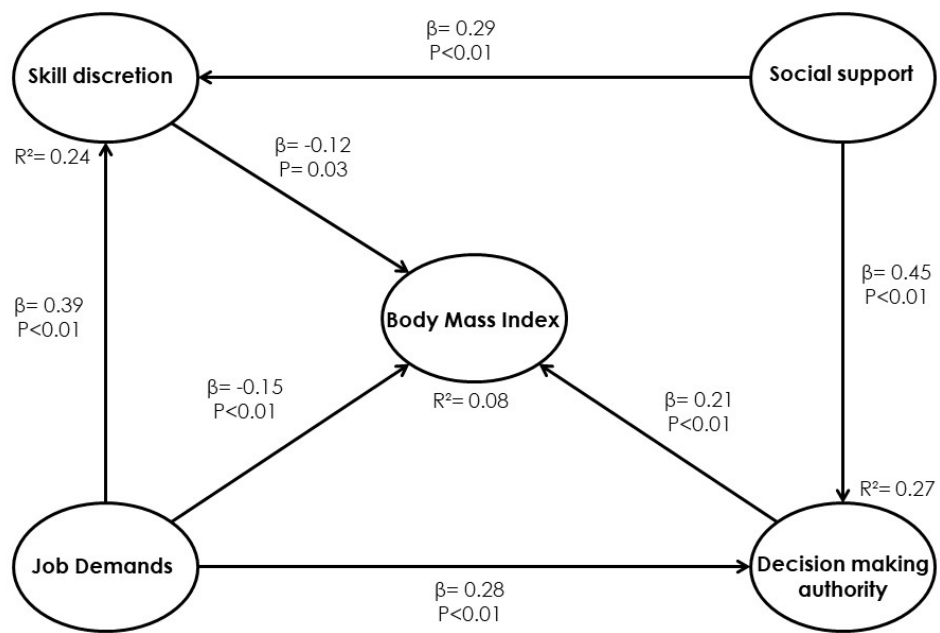
Figure 2. Final Model 1 for the relationships between the Job Content Questionnaire (JCQ) dimensions and BMI.